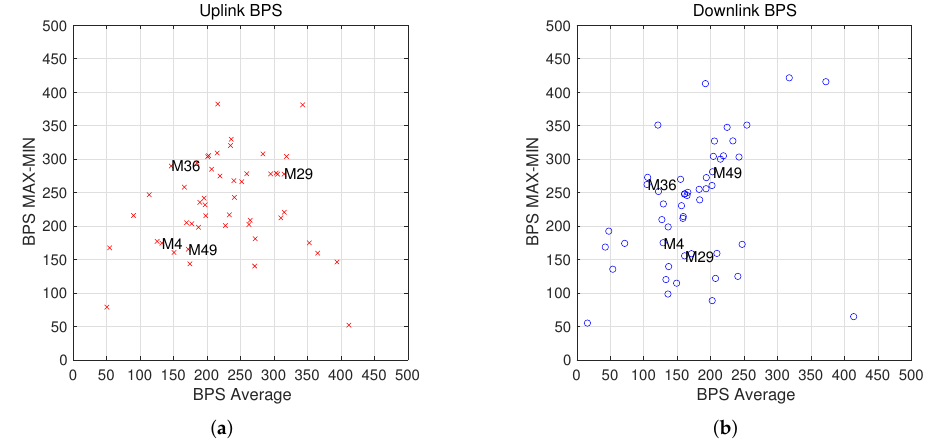
Figure 5. Example of BPS features (Daejeon TS, DCU 5, modem 5). ( a ) Basic statistical features (F1–F3; average, maximum, and minimum per day). ( b ) Link BPS features (F15–F17; average, maximum, and minimum per day).